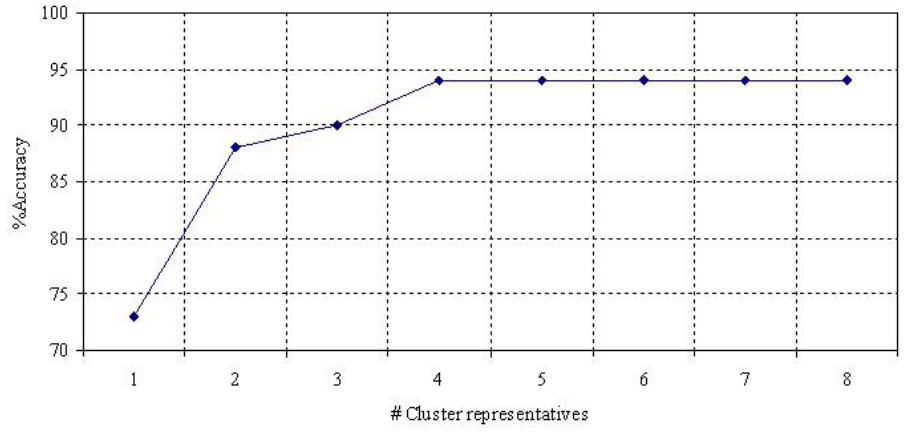
Fig 7: Retrieval accuracy of proposed MFCR method at a different number of cluster representatives. Results are reported using 1–NN classifier.